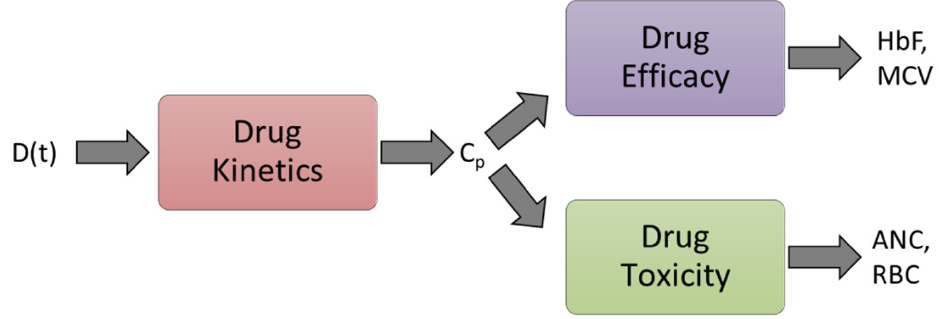
Figure 3. Integrated PK-PD model components. D(t), dose; C p , HU plasma conc.; HbF, fetal hemoglobin; MCV, mean cell volume of red blood cell; ANC, absolute neutrophil count; RBC, red blood